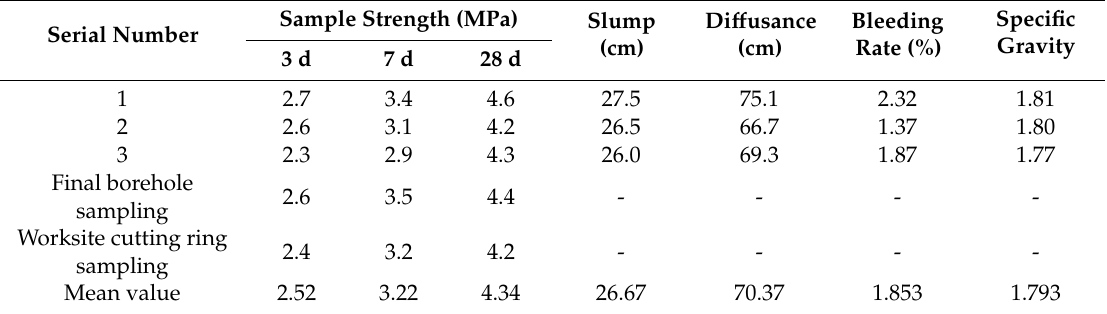
Table 5. Monitoring results of tailings-hemihydrate phosphogypsum filling slurry preparation quality.